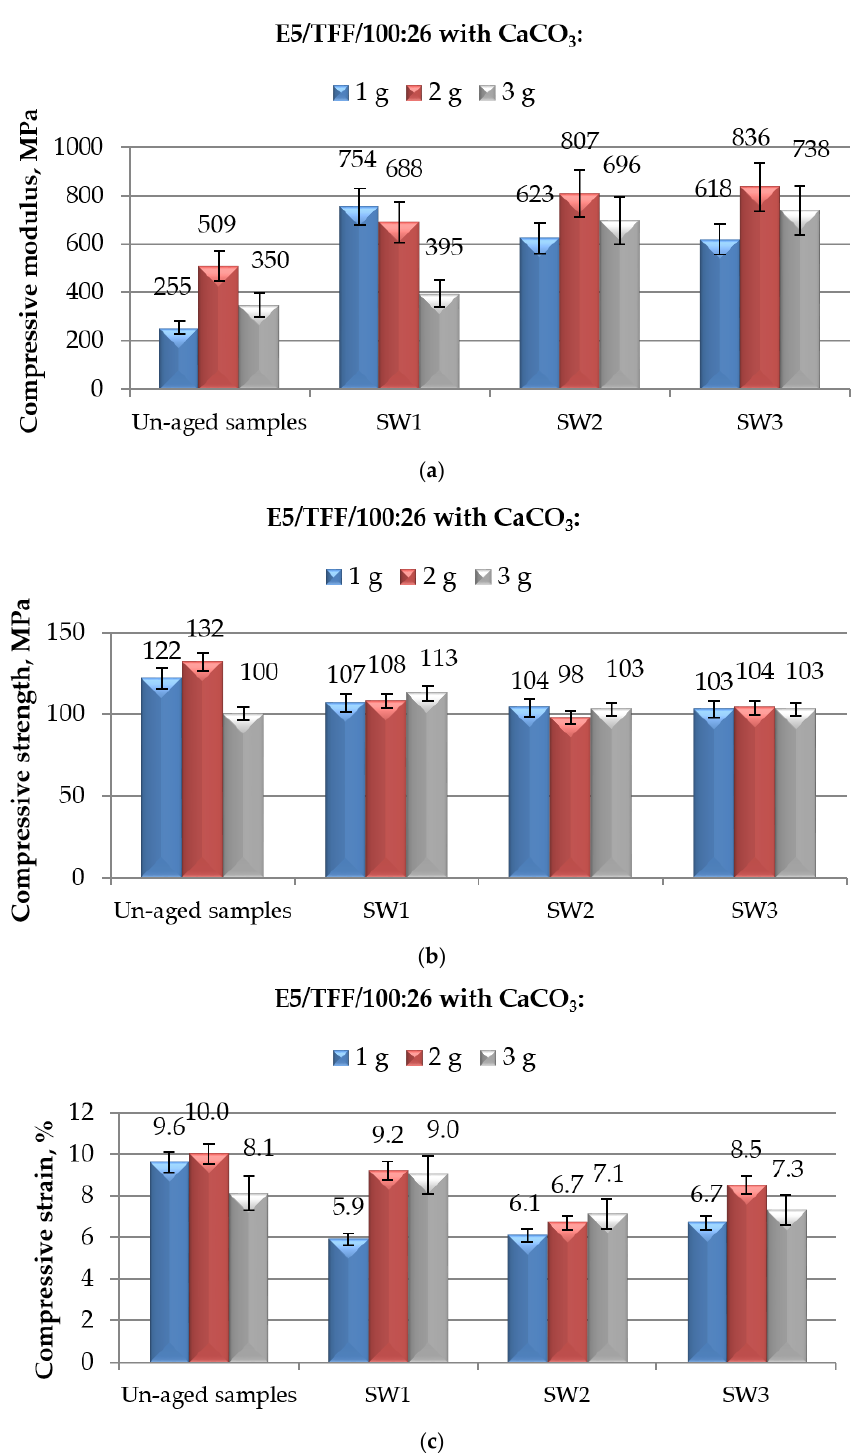
Figure 8. Results of mechanical (in compression mode) tests performed on E5/TFF/100:26 epoxy compounds filled with different amounts of CaCO 3 and aged for different time spans (from 1 to 10 months) in spring water: ( a ) Compressive modulus; ( b ) compressive maximum strength; and ( c ) compressive strain at